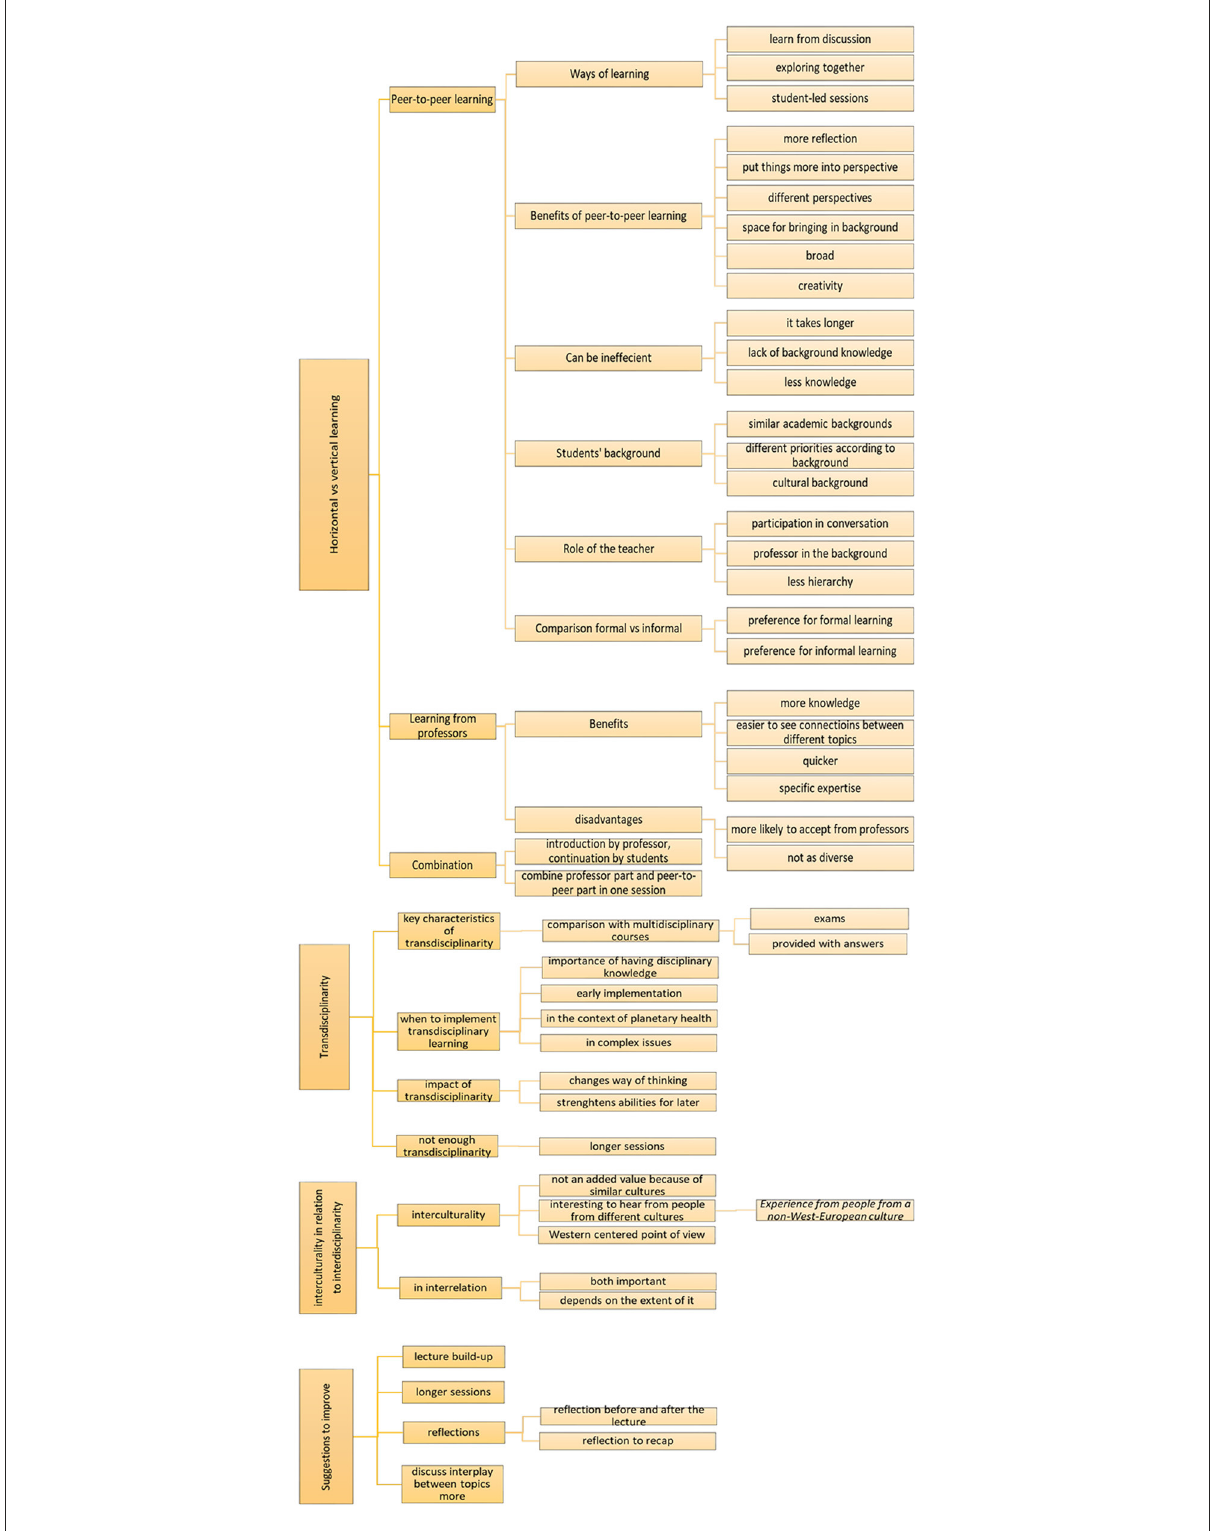
FIGURE1 Overview of the themes, subthemes and codes used for the thematic